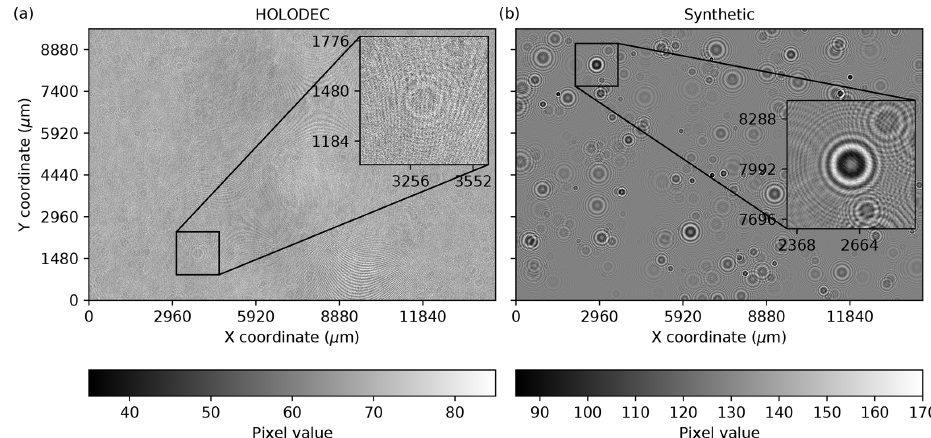
Figure 1. (a) An example hologram obtained from HOLODEC. (b) A synthetic hologram obtained from a simulation. The inset box in each map illustrates an out-of-focus particle. The pixel values ranged from 0 to 255 in each